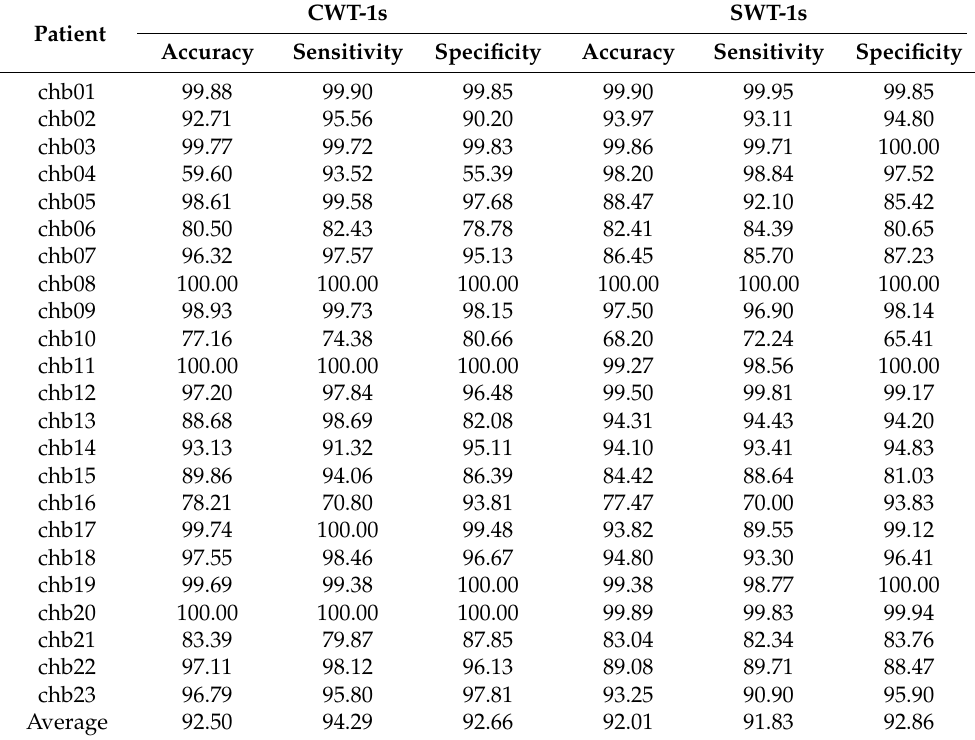
Table 3. The comparison of 1 s CWT and SWT segments under VGG16 model.